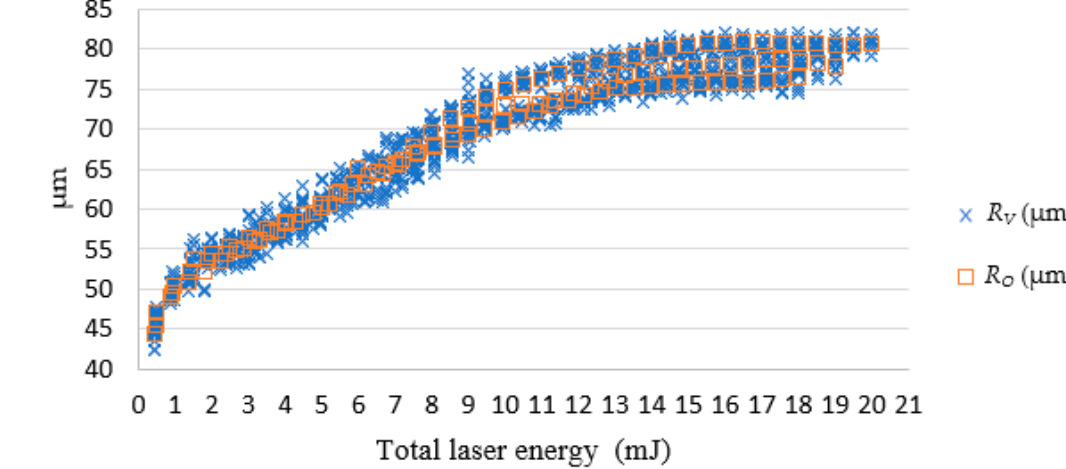
Figure 13. The SLDM-simulated R O and the actual diameter R V .